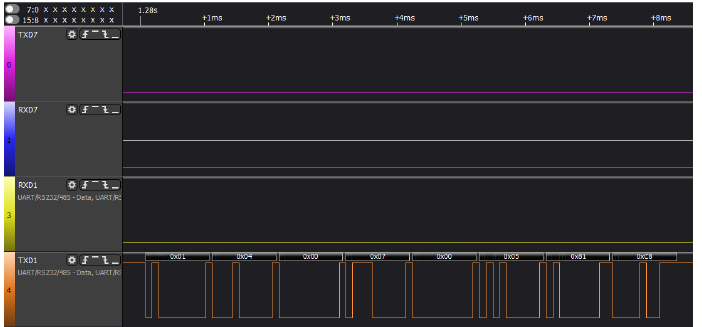
Figure A3. UART Communication(Read Data!) from RoLa module to Host